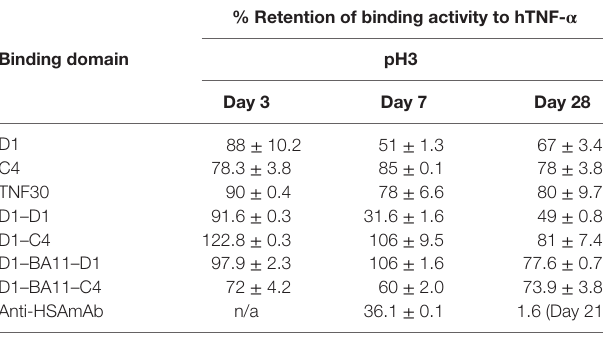
VNAR protein samples incubated at pH 3 for 3–28 days were neutralized in phosphate buffered saline, pH 7.4 to a final concentration of 0.5 µg/ml before loading onto a 1 µg/ ml hTNF- α and/or human serum albumin (HSA)-coated ELISA plates. Binding activity was measured as percentage residual activity compared to an untreated control at each time point. Results shown are the mean ± SD (n = 1 with multiple replicates per experiment). The control anti-human serum albumin monoclonal is clone HSA-11 produced in mouse (Sigma, A6684).